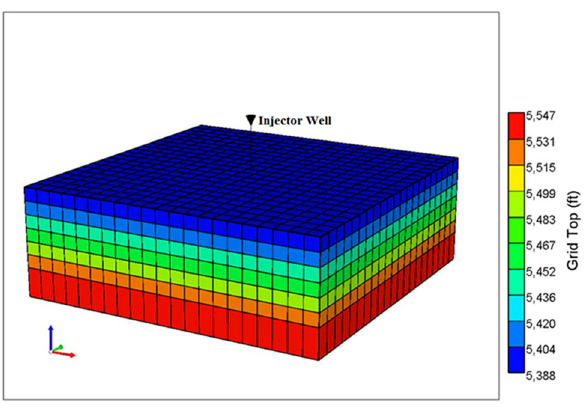
Fig. 2 Model schematic for simulation of synthetic case